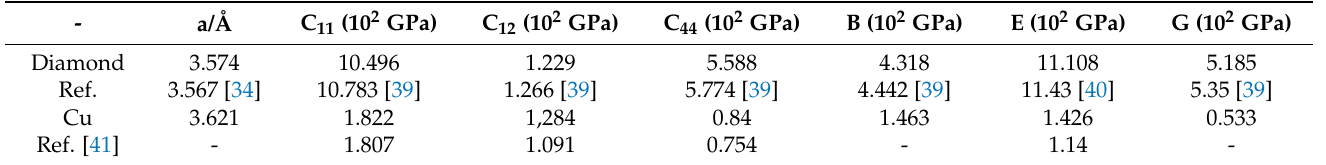
Table 2. The calculation of elastic constants and elastic moduli of copper and diamond.